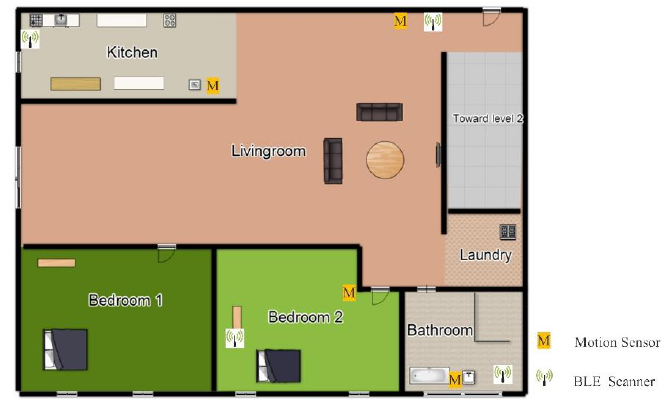
Figure 5. Single resident smart home architecture.